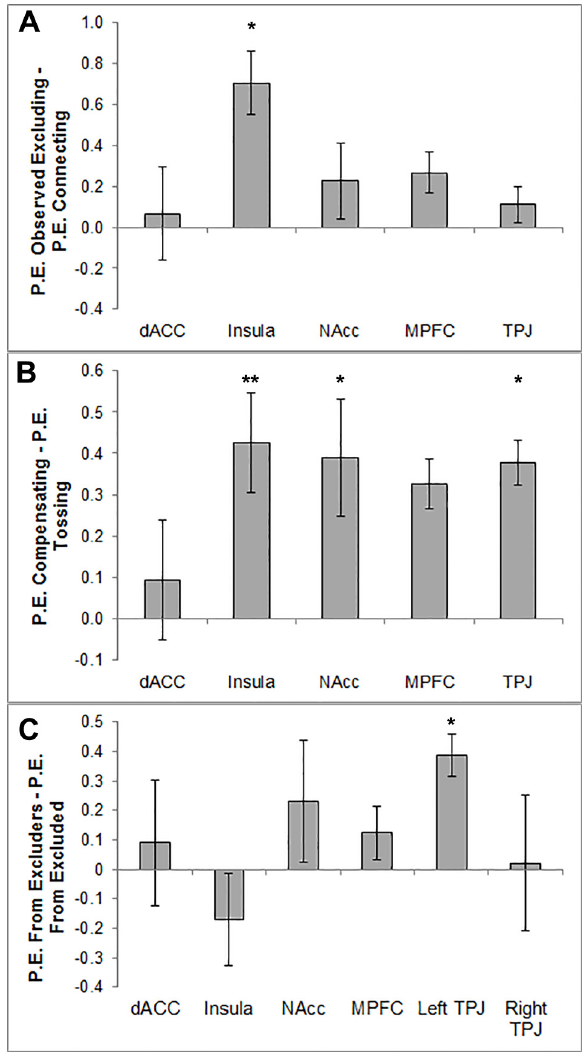
Fig 3. Difference scores of activity in ROIs for the three condition contrasts. P.E. = parameter estimates. One asterisk ( * ) indicates p < .05, two asterisks ( ** ) indicate p < .01, and three asterisks ( *** ) indicate p < .005. Error bars represent Standard Errors (SE) of the mean. In case no significant differences were found between hemispheres, findings are presented collapsed across left and right lateralized areas. (A): Difference score of activity in the ROIs for Observed Excluding – Connecting. (B): Difference score of activity in the ROIs for Compensating — Tossing. (C): Difference score of activity in the ROIs for receiving the ball From Excluders – receiving the ball From